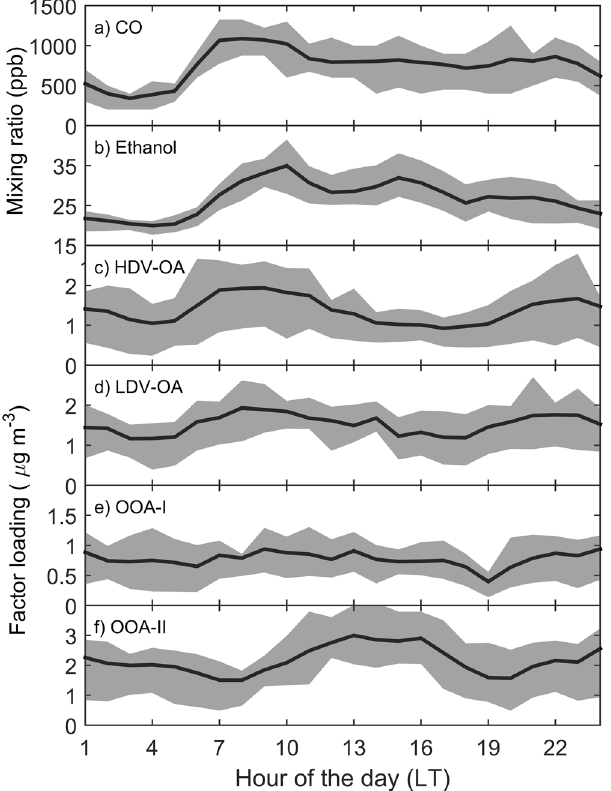
Figure 2. Weekday diurnal profile of CO ( a ), ethanol ( b ), HDV factor ( c ), LDV factor ( d ), OOA-I factor ( e ), OOA-II factor ( f ). Black line represents median and grey area the interquartile range.